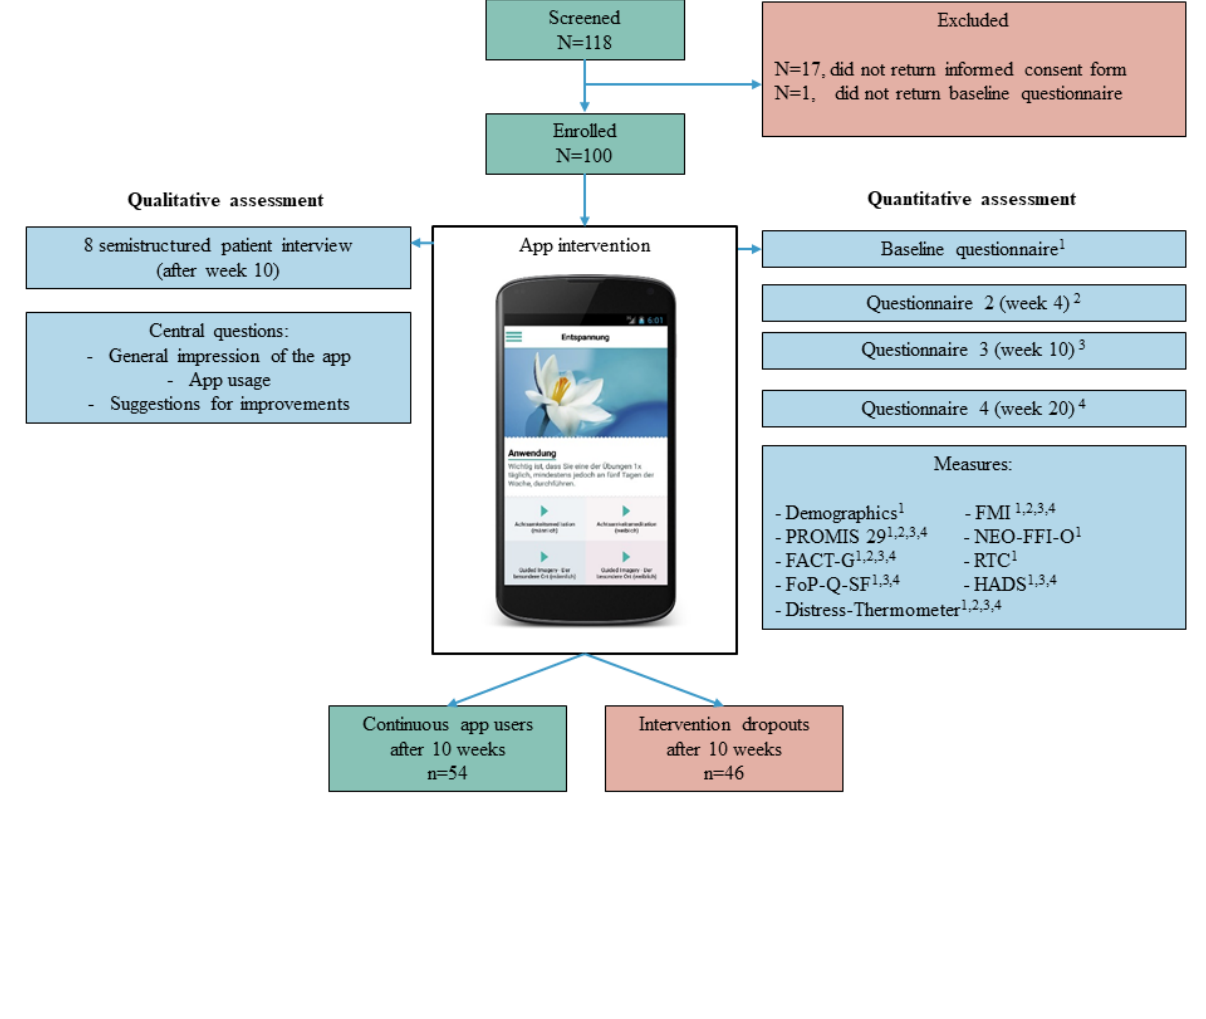
Figure 1. Patient flowchart. FMI: Freiburg Mindfulness Inventory; PROMIS 29: Patient Reported Outcomes Measurement Information System 29; NEO-FFI-O: NEO Five-Factor Inventory - openness to experience; FACT-G: Functional Assessment of Cancer Therapy-General; RTC: Resistance to Change; FoP-Q-SF: Fear of Progression Questionnaire - Short Form; HADS: Hospital Anxiety Depression